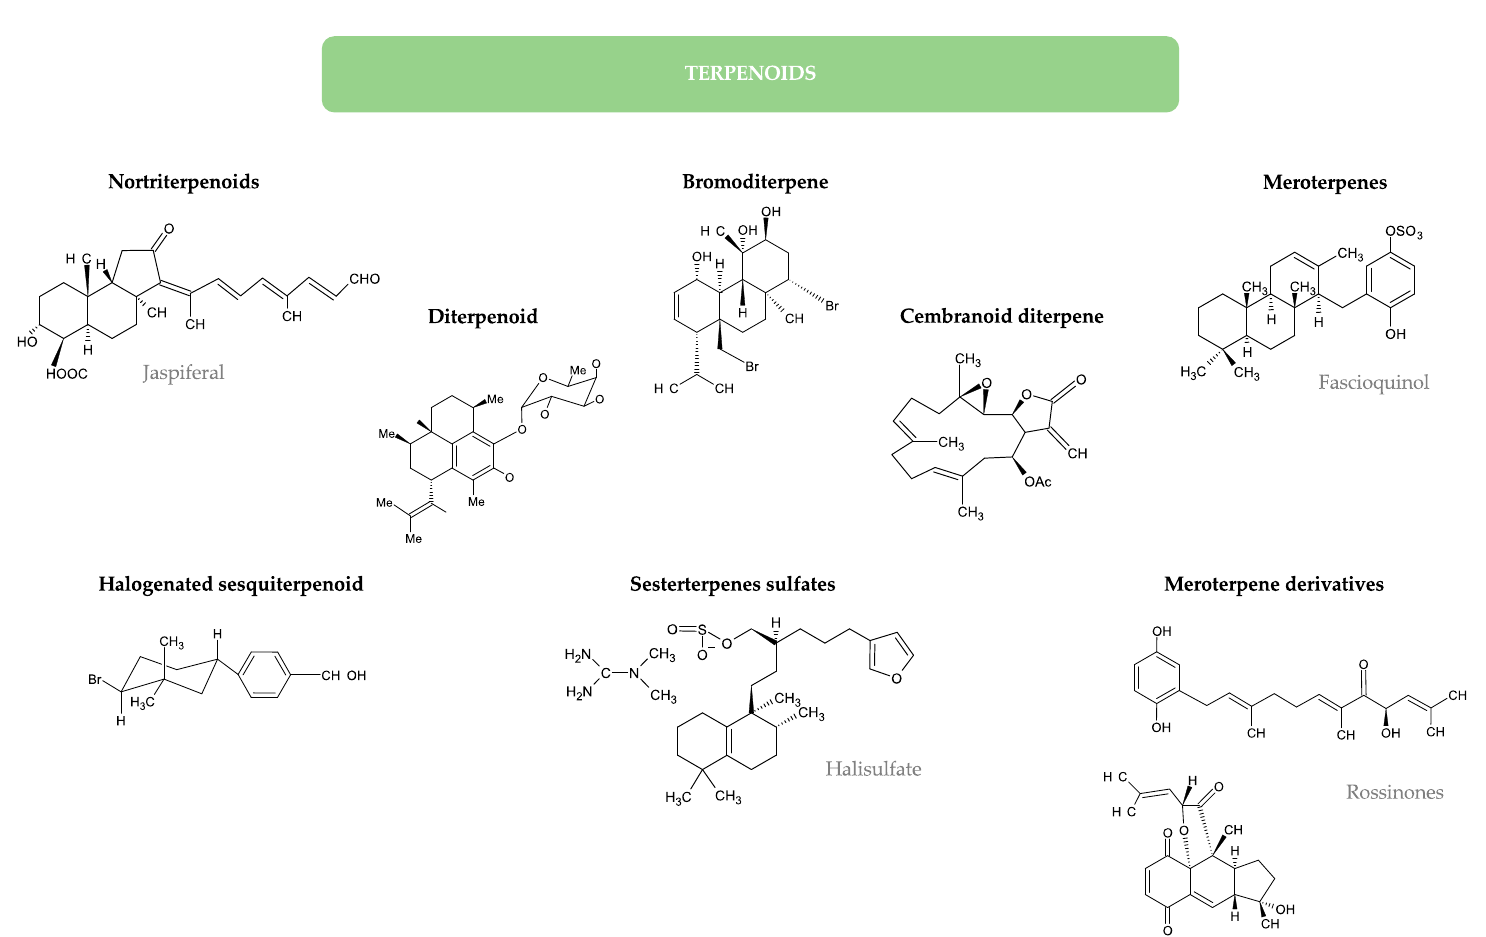
Figure 2. Chemical structures of the di ff erent lipid classes isolated from natural sources with antimicrobial